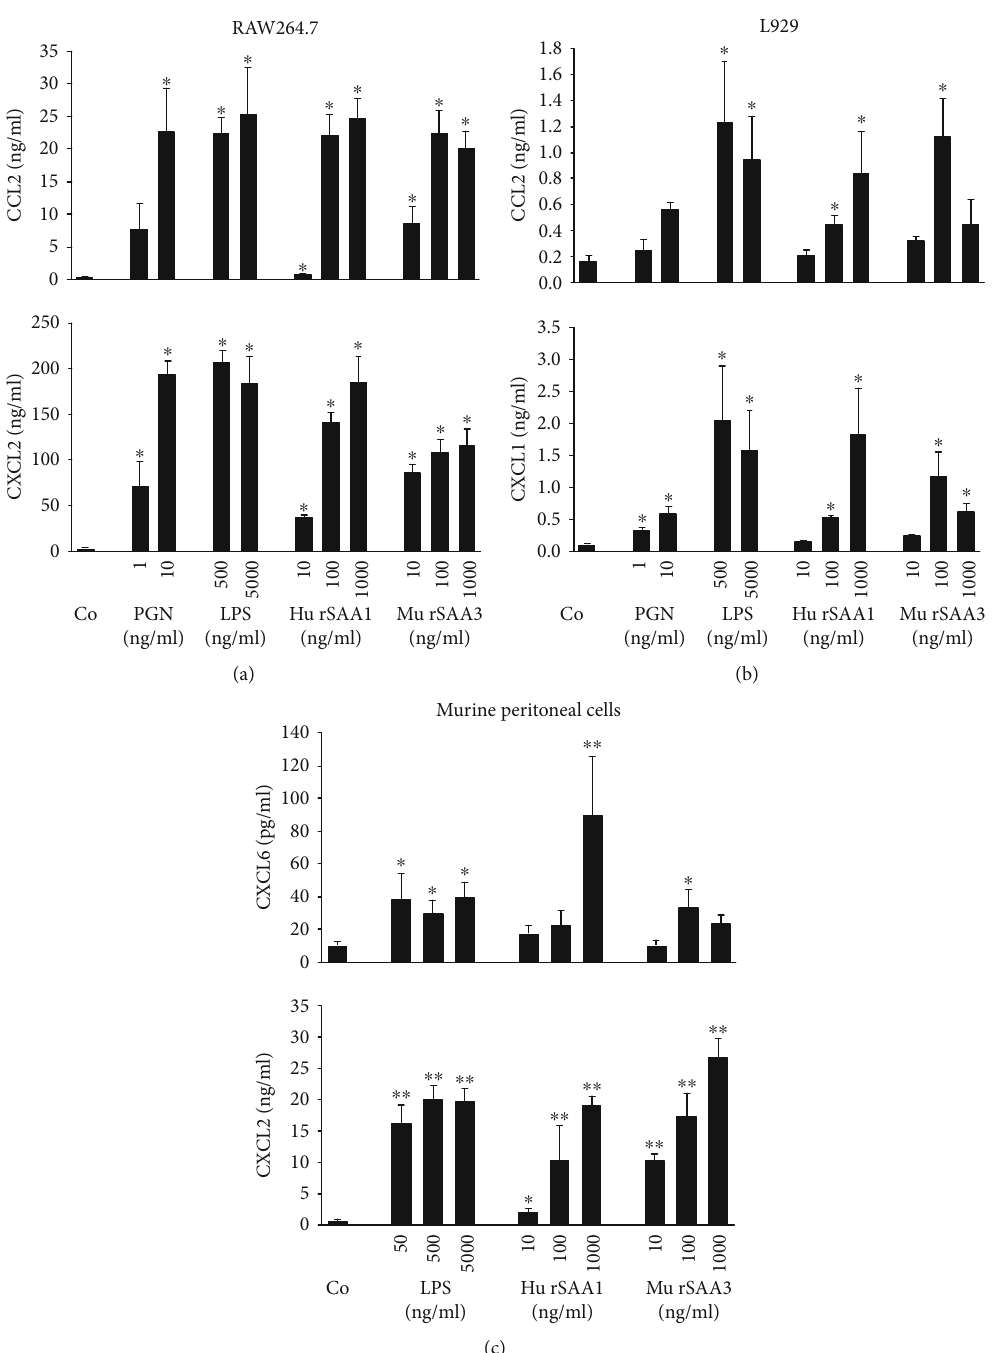
Figure 3: Impure mu rSAA3 induces chemokines in murine RAW264.7 macrophages, L929 fi broblasts and peritoneal cells. Murine RAW264.7 macrophages (a), murine L929 fi broblasts (b) and murine peritoneal cells derived from healthy mice (c) were stimulated with di ff erent concentrations of PGN (1 or 10ng/ml; a and b), LPS (500 or 5000ng/ml (a and b) or 50-5000 ng/ml (c)), hu rSAA1 (10- 1000ng/ml), mu rSAA3 (10-1000ng/ml) or were left untreated (Co). After 24 h, supernatants were collected and the production of CCL2 (a and b), CXCL1 (b), CXCL2 (a and c) and CXCL6 (c) was determined via speci fi c ELISAs. Data represent the mean production of chemokine ± SEM derived from 4 to 5 (a and b) or 6 (c) independent experiments. Statistically signi fi cant di ff erences from untreated control cells, determined by the Mann-Whitney U test, are indicated by asterisks ( ∗ p < 0 : 05 ; ∗∗ p < 0 : 01 In contrast, hu rSAA1 at 3000 ng/ml weakly stimulated (Figure 4(a)). Mu rSAA3 provoked a strong chemotactic neutrophil migration ( CI = 5 : 1 ± 3 : 1 ; n = 5 ; p < 0 : 05 ). As a response of neutrophils from 1000 ng/ml onwards, reaching control, the established neutrophil chemoattractant CXCL8 a maximal CI of 41 : 1 ± 19 : 4 at 3000 ng/ml ( n = 5 ; p < 0 : 05 ).